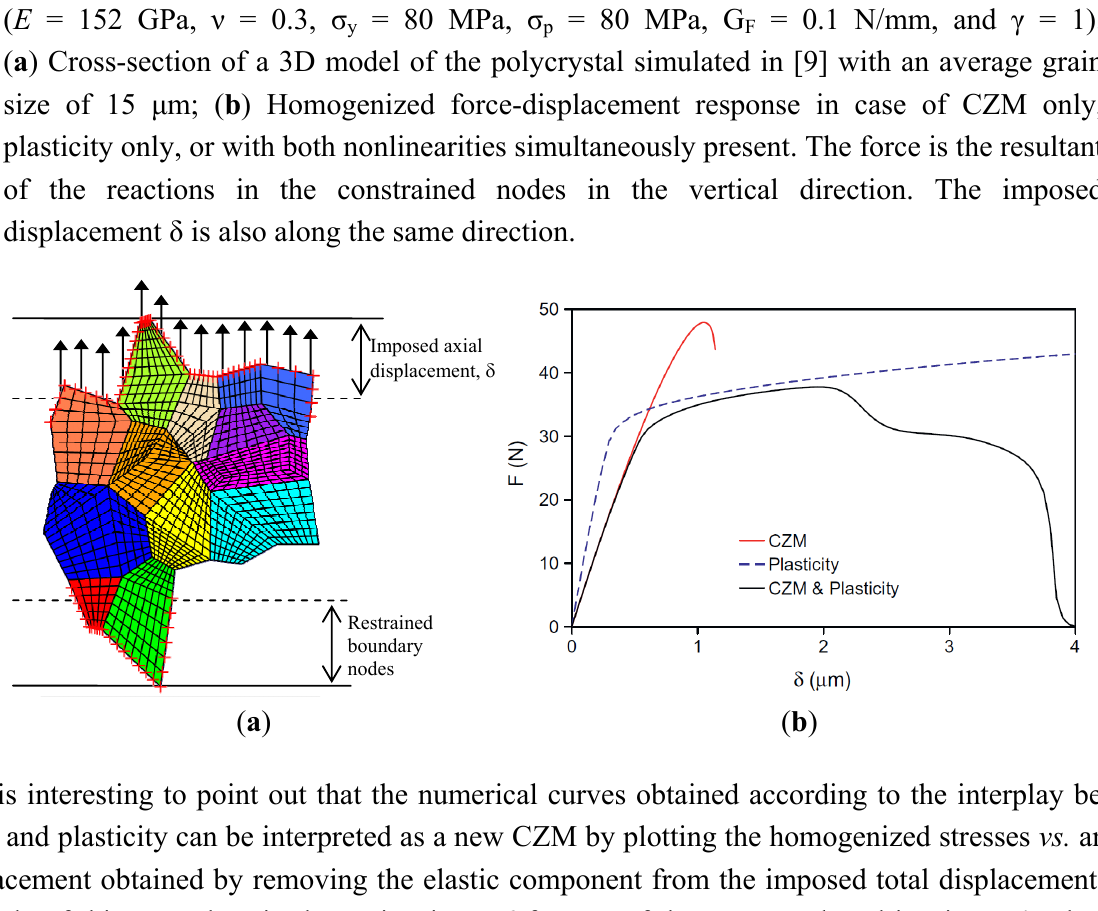
Figure 5. Homogenized uniaxial response of a polycrystalline material in tension ( E = 152 GPa, ν = 0.3, σ = 80 MPa, σ = 80 MPa, G = 0.1 N/mm, and γ = 1). y p F ( a ) Cross-section of a 3D model of the polycrystal simulated in [9] with an average grain